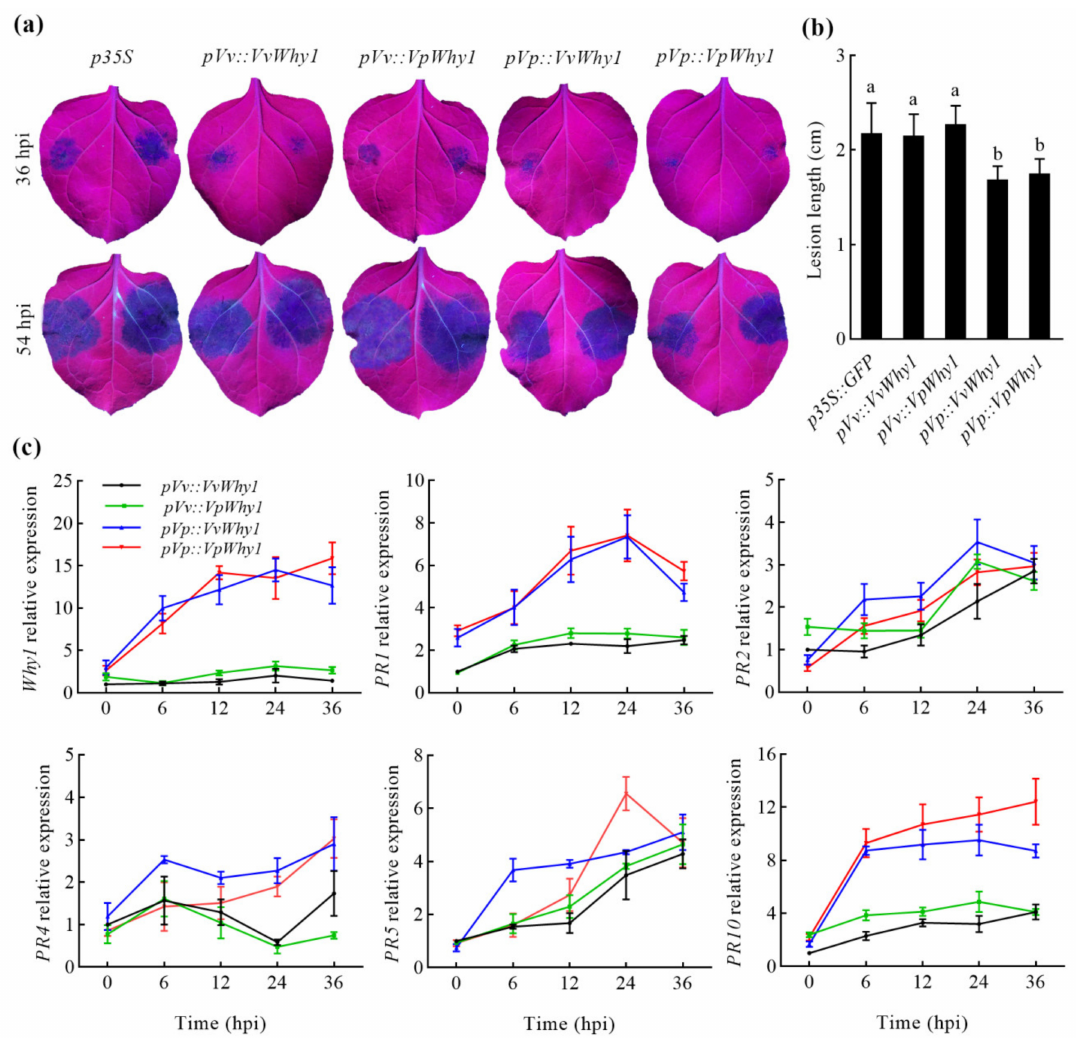
Figure 7. Lesion symptoms of transient transgenic N. benthamiana and transcriptional expression of Why 1 and PR genes in response to P. capsici . ( a ) Lesion symptoms of transient transgenic N. benthamiana at 36 and 54 hpi. ( b ) Lesion length of transient transgenic N. benthamiana leaves (different letters indicate significant difference at 0.05 level). ( c ) Transcriptional expression of Why 1 and PR genes in response to P. capsici . Why1 , PR1 and PR10 are significantly induced in pVp transient transgenic treatments, while the expression remains at a lower level in pVv treatments. Vertical bars represent standard deviations; different letters indicate significant differences at the 0.05 level. hpi indicates hours